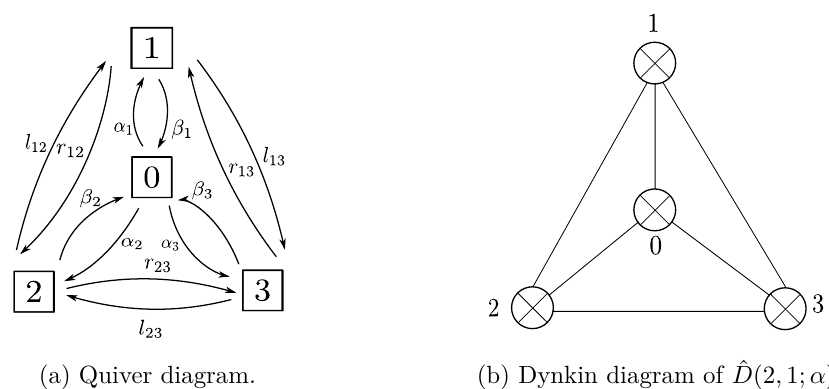
ˆ D (2 , 1; α ) . We choose all of